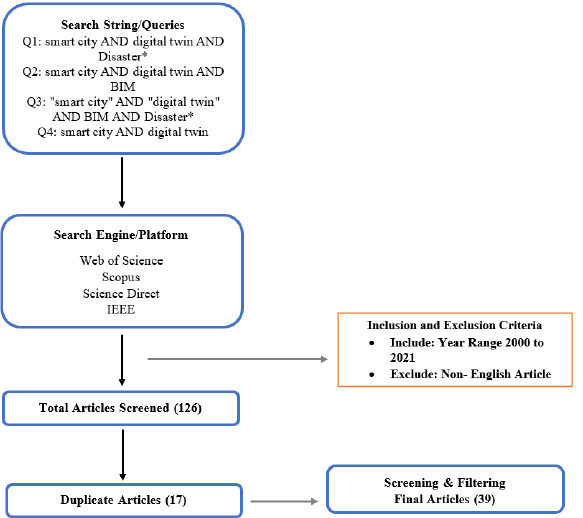
Figure 2 . Simplified diagram with additional information.